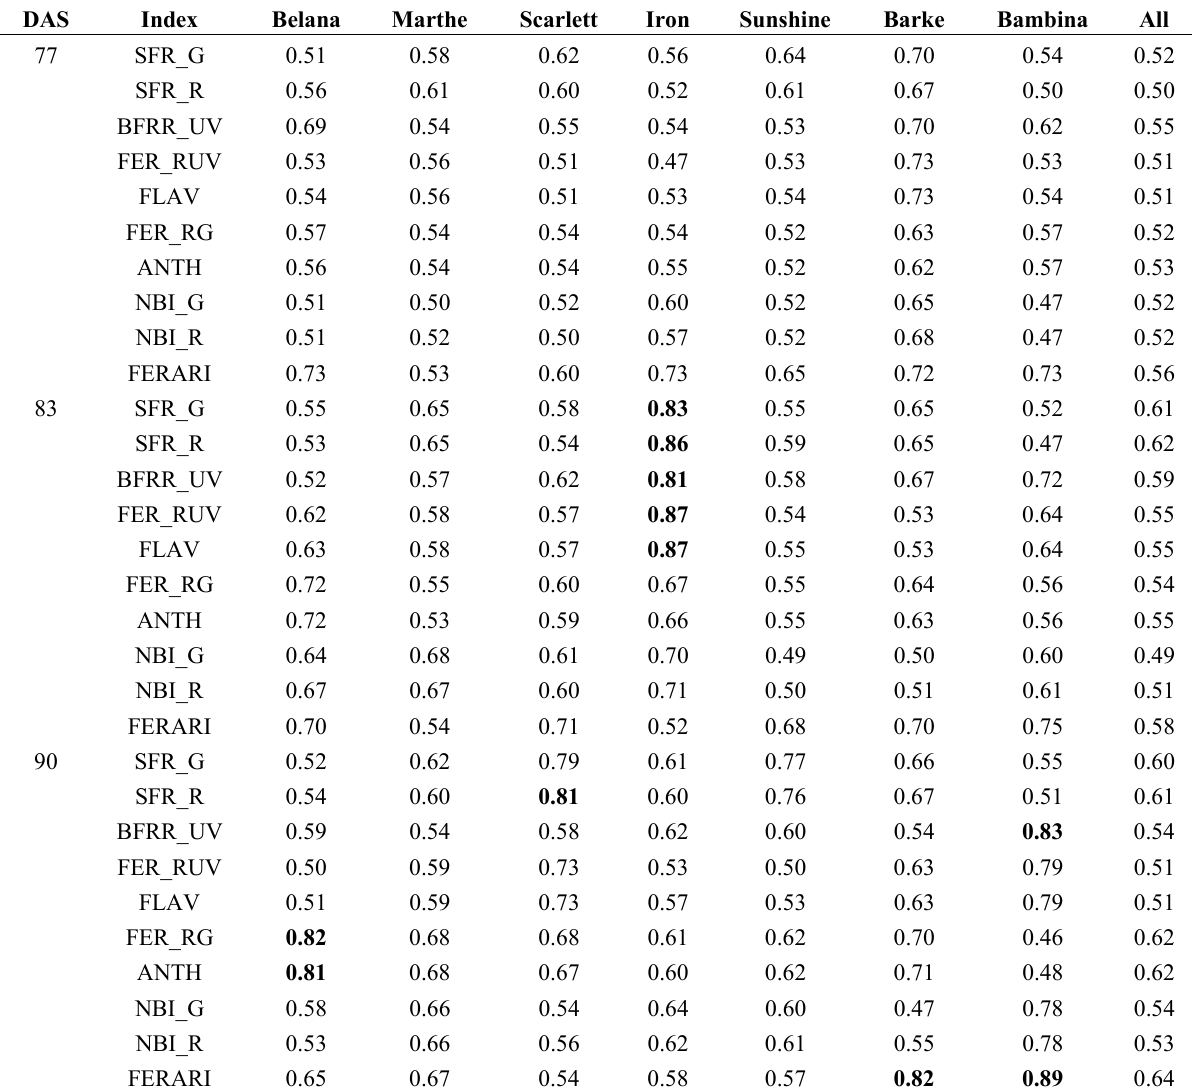
Table 4. The c statistic showing the performance of fluorescence indices in discriminating between the with- and without-fungicide treatments (bold font highlights c -values that are not less than